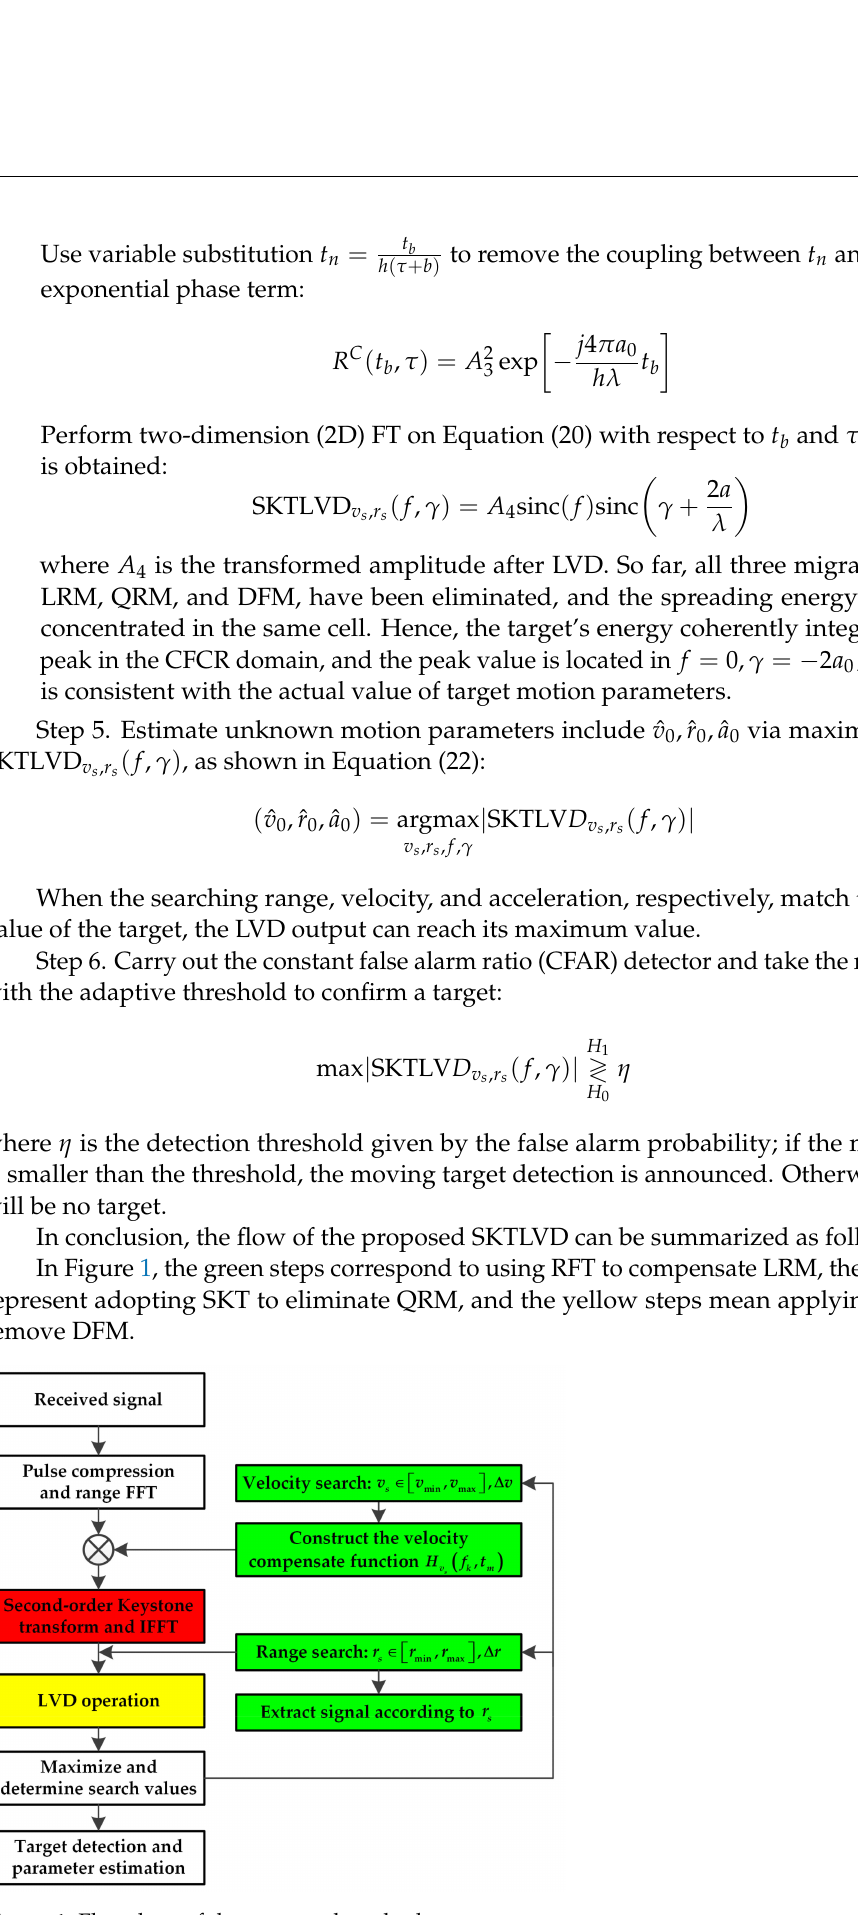
Figure 1. Flowchart of the proposed